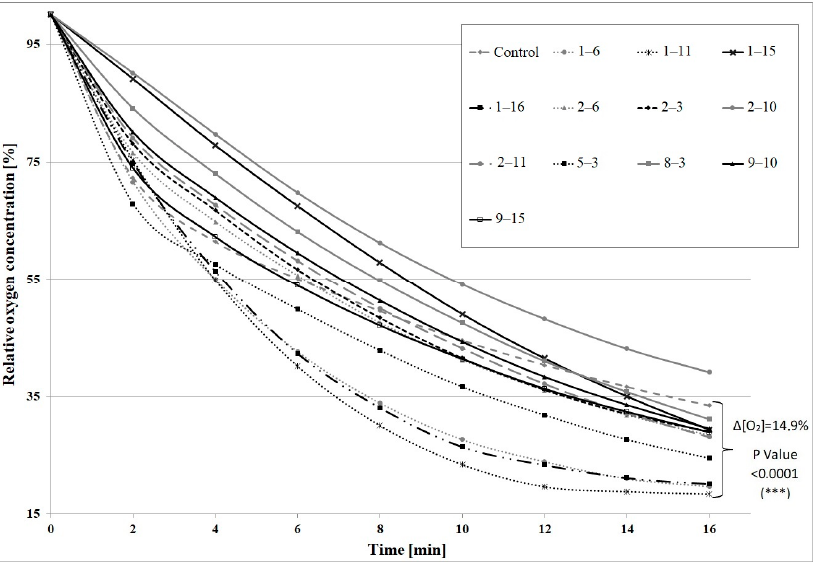
Figure 1. General metabolic activity (GMA) of 12 mutants of C. pannorum A-1 adapted to toxic β -pinene and selected for their high biotransformation ability. A non-treated wild strain was used as a control. Biomass concentration in each sample was 5 g dry mass per